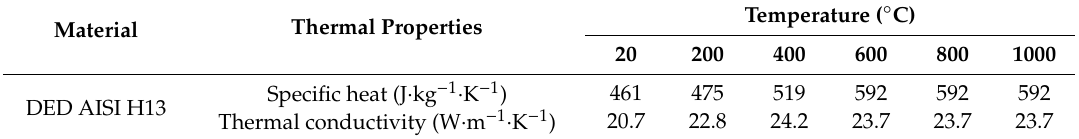
Table 7. E ff ective thermal conductivity of the DED AIS H13 considered in the thermal model.